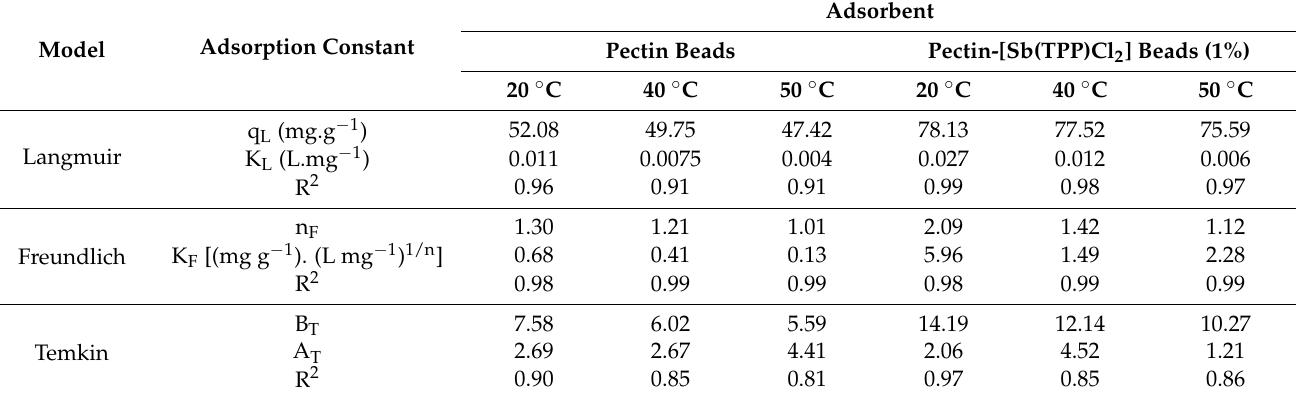
Table 4. Isotherm constants calculated for pectin beads and pectin-[Sb(TPP)Cl 2 ] beads (1%).